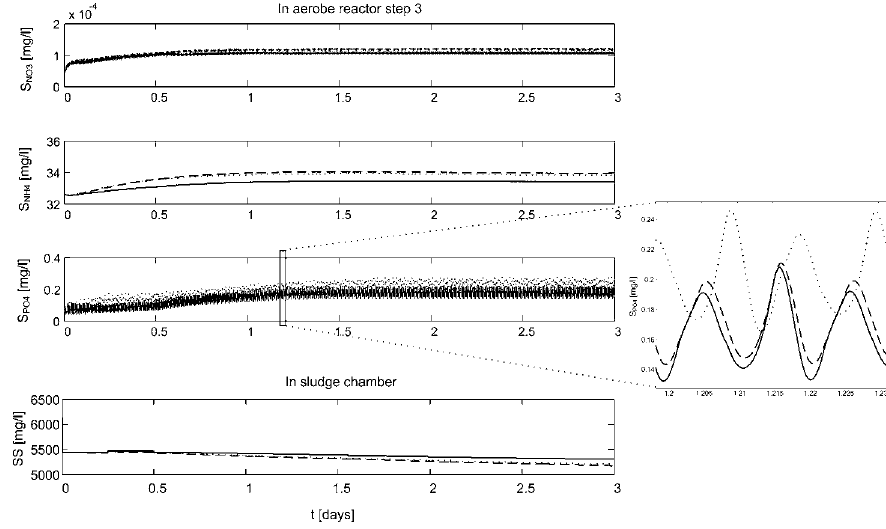
Figure 3. Comparison of model outputs: y t (cid:1) y m